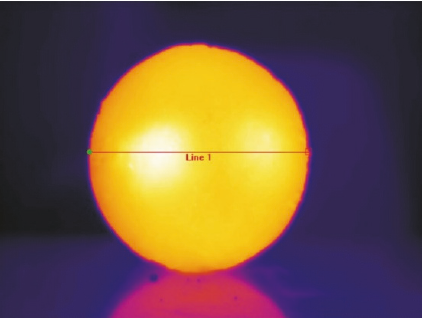
Figure 3: Line 1 is used to plot a temperature related graph of the surface of the specimen.